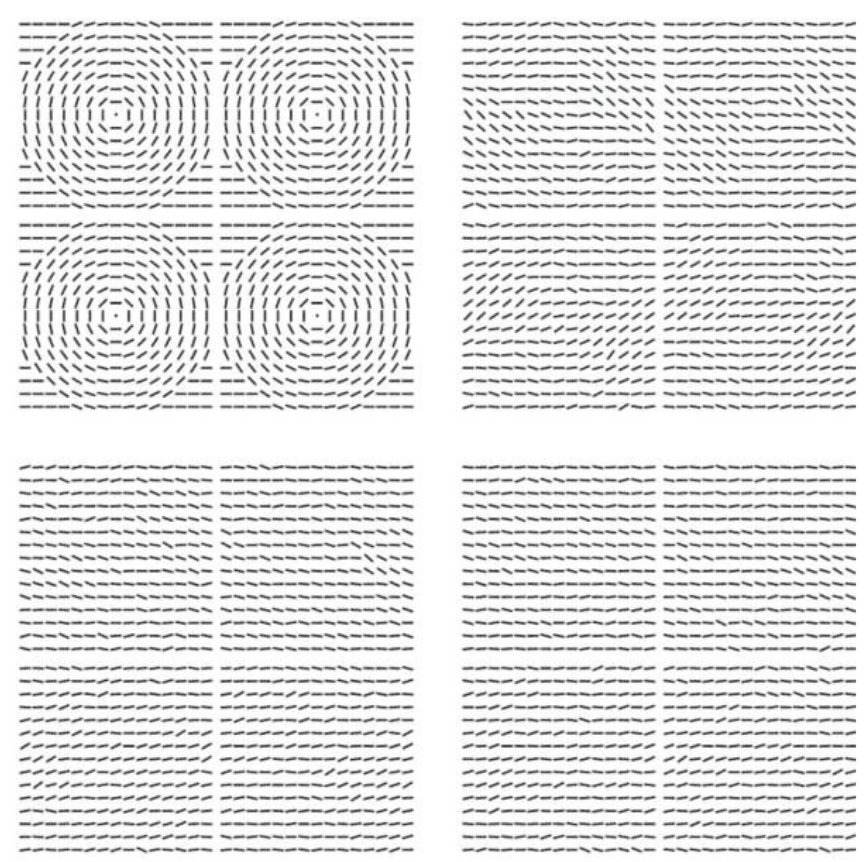
Figure 2: Spin configurations in different “horizontal” planes for the cell with thickness L = 30: k = 0 (top left, as for Figure 1), k = 5 (top right), k = 10 (bottom left), and k = 15, middle of the cell (bottom